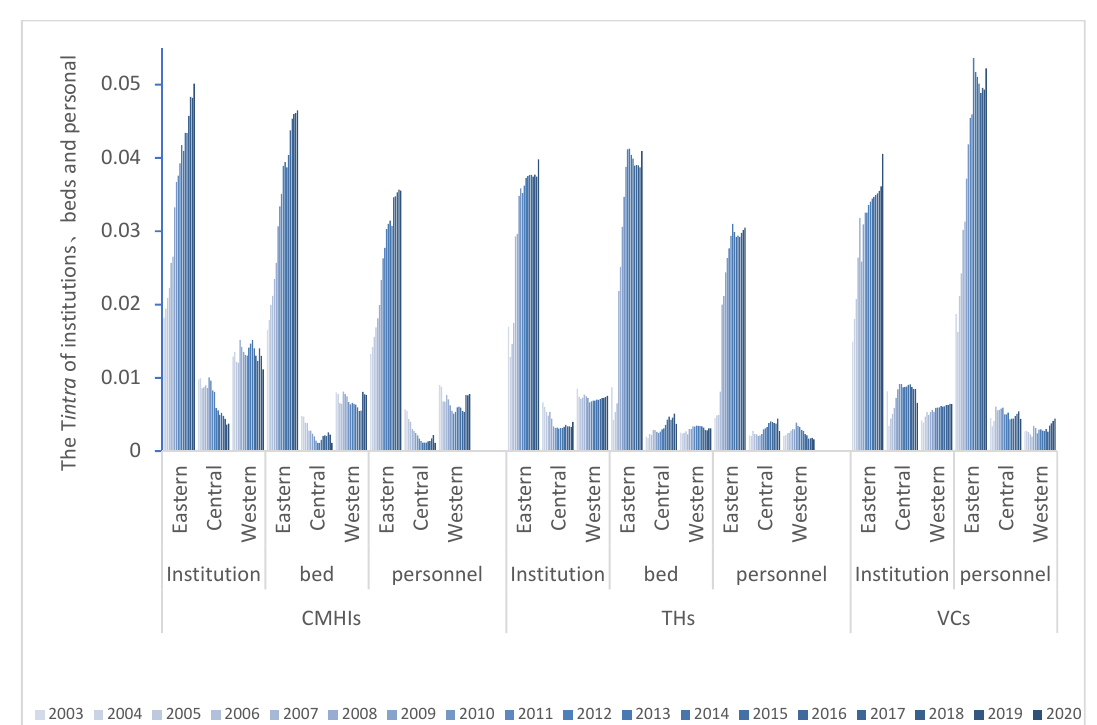
Figure 8. Changes in T intra of health resources allocation in the eastern, central and western regions from 2003 to 2020 (CMHIs: county and county-level city medical and health institutions; THs: township hospitals; VCs: village clinics).